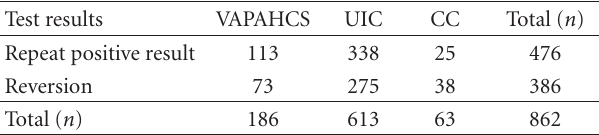
Table 1: Test results for analyzed HCWs from VA Palo Alto Health Care System (VAPAHCS), University of Illinois Chicago (UIC) and the Cleveland Clinic